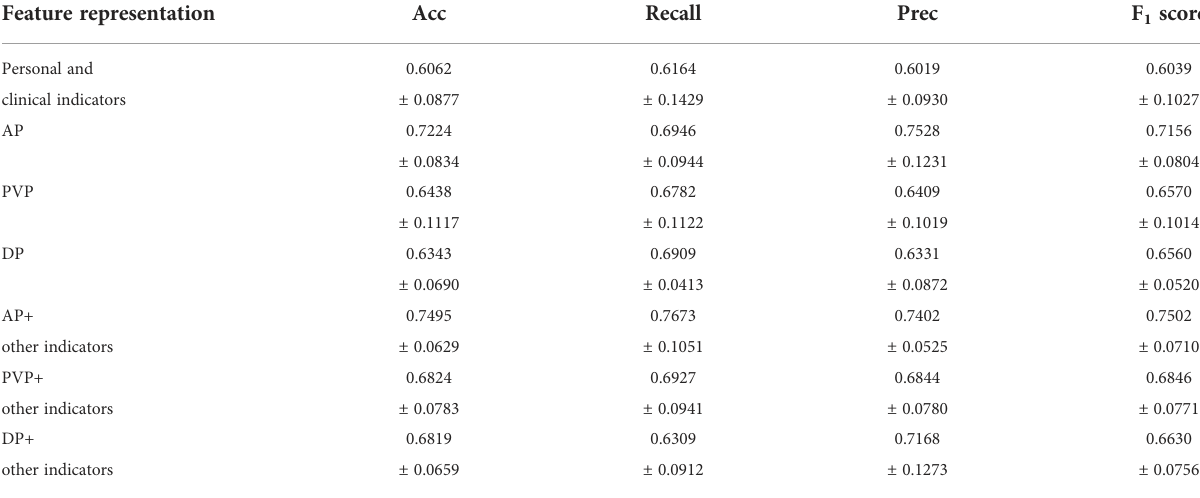
TABLE 2 Comparison of recurrence prediction results of ensemble learning models using different feature representations. Feature